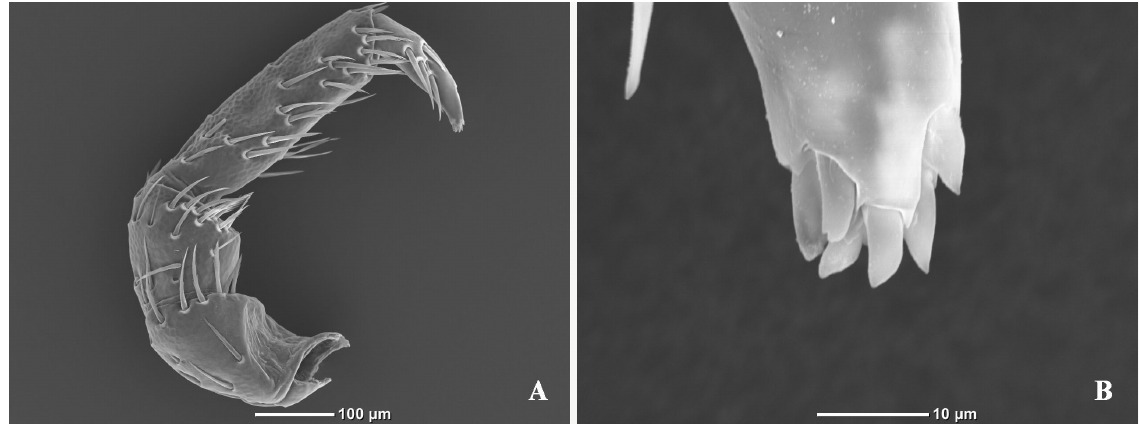
Fig. 4. Eylais ( Meteylais ) hamata Koenike, 1897, SEM photographs, ♂ (GUGC QH-EY-20200803). A . Palp-2–5. B . Palp-5,